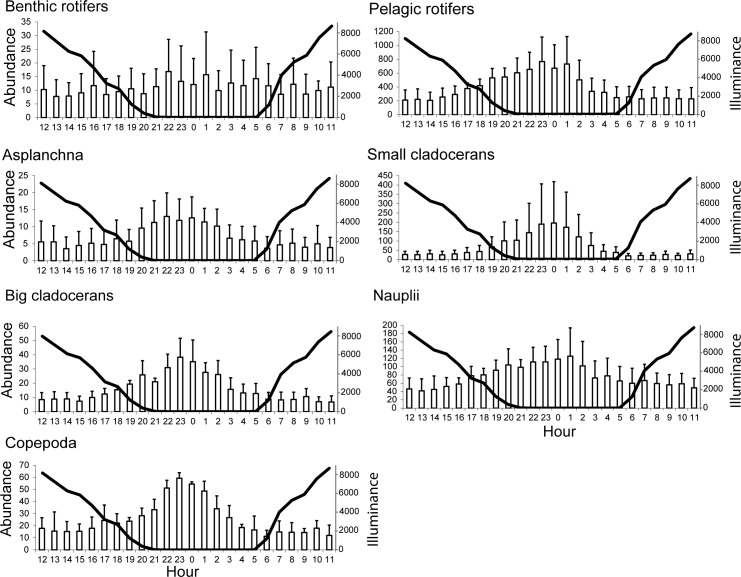
Mean + SD of the zooplankton abundance (ind. l-1) in the outflows of the examined lakes in relation to the mean illuminance values (lux) (solid line).